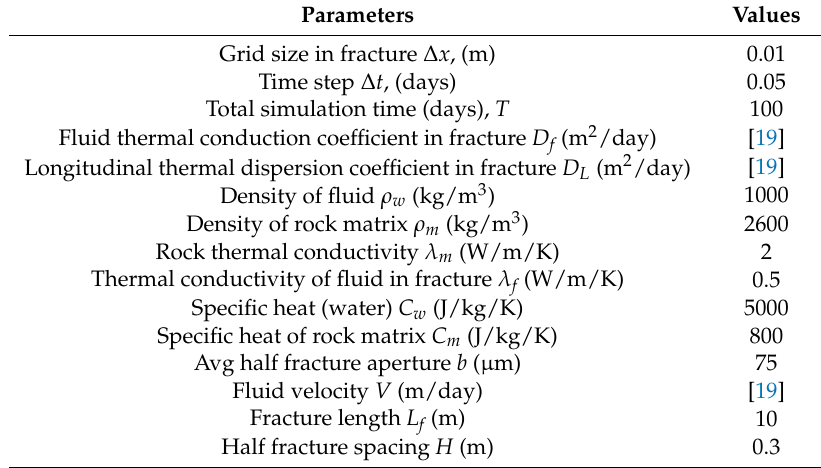
Values of the parameters used for validation of the numerical model for parallel fracture